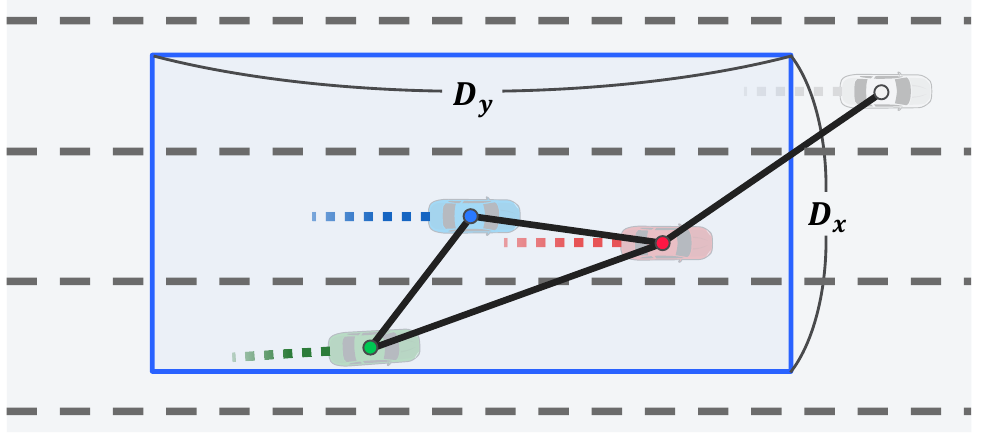
Figure 4. Graph construction based on distance among vehicles in Stage